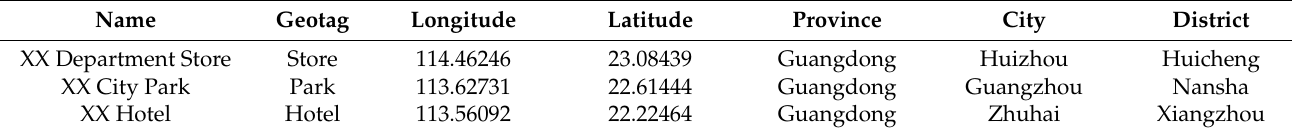
Table A1. The example of POI data from AMAP.